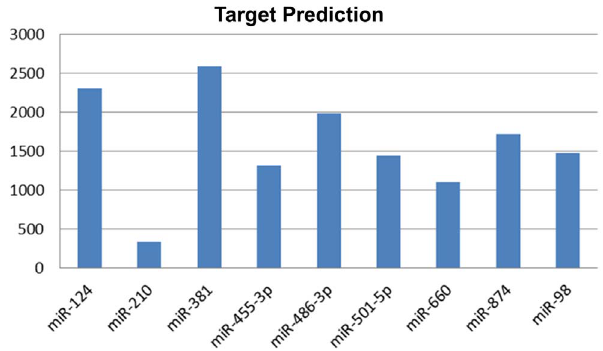
Figure 2. Target prediction graph. Graph displaying the number of predicted targets from miRWalk for each miRNA differentially expressed between F-BC and NF-BC groups. F-BC, familial breast cancer; NF-BC, non-familial breast